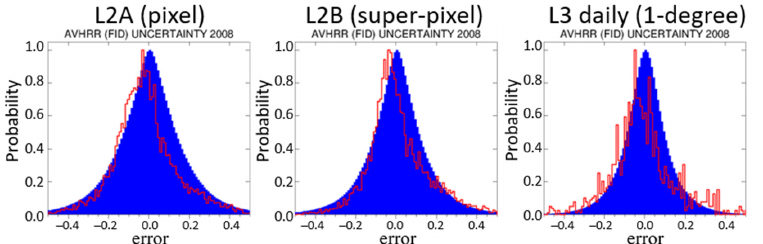
Figure 9. Probability distributions of the estimated true error vs. AERONET (in red) and errors derived from uncertainties (in blue) for different product levels of the AVHRR AOD dataset (2008): (from left to right ) pixel level, super-pixel level, daily gridded level.